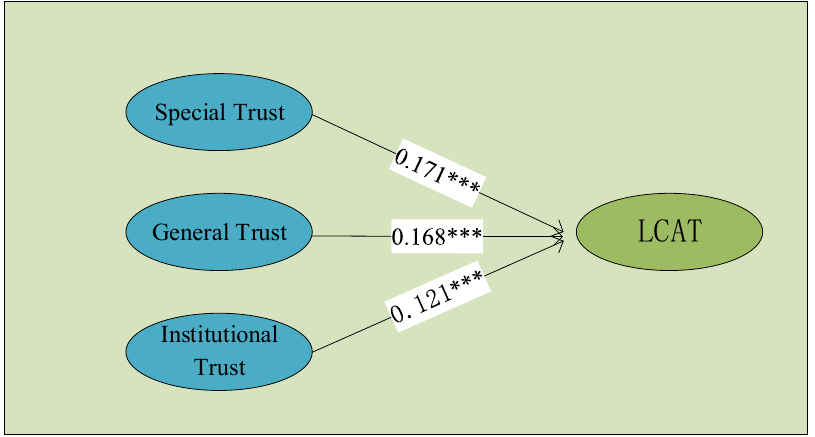
Figure 2. The regression results of farmers’ trust in LCAT. Note: ***, **, * mean that the estimated results are significant at 0.01, 0.05, 0.1.